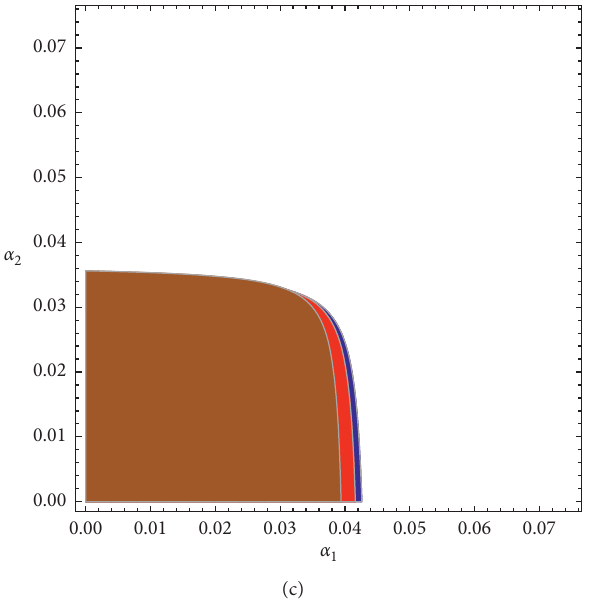
Figure 3: The influence of the parameters δ and b